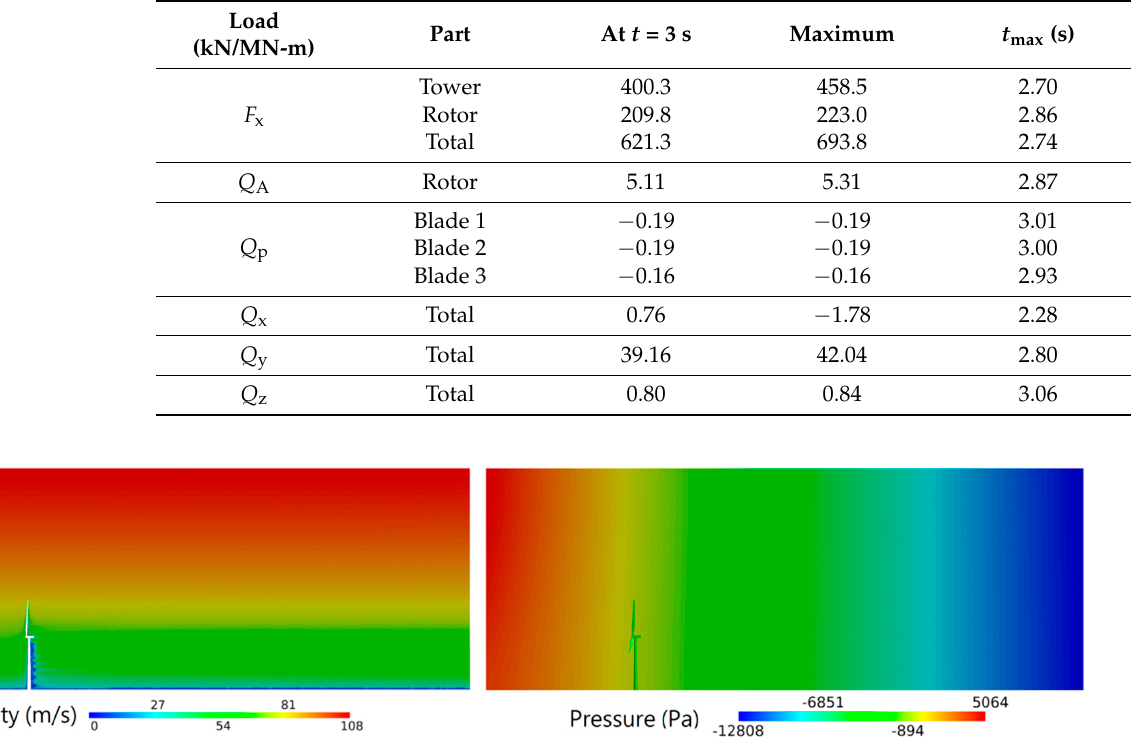
Table 6. Wind loads under unsteady extreme gust for the blade configuration of 0°–120°–240°.